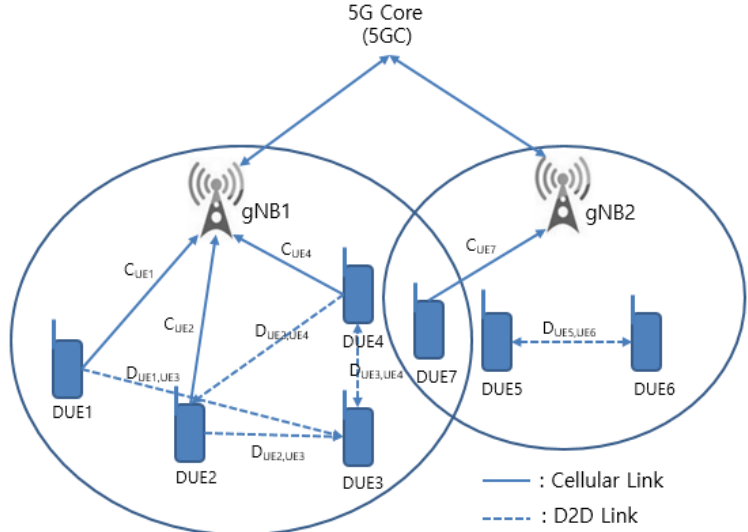
Figure 1. Cellular link and D2D link in 5GC.